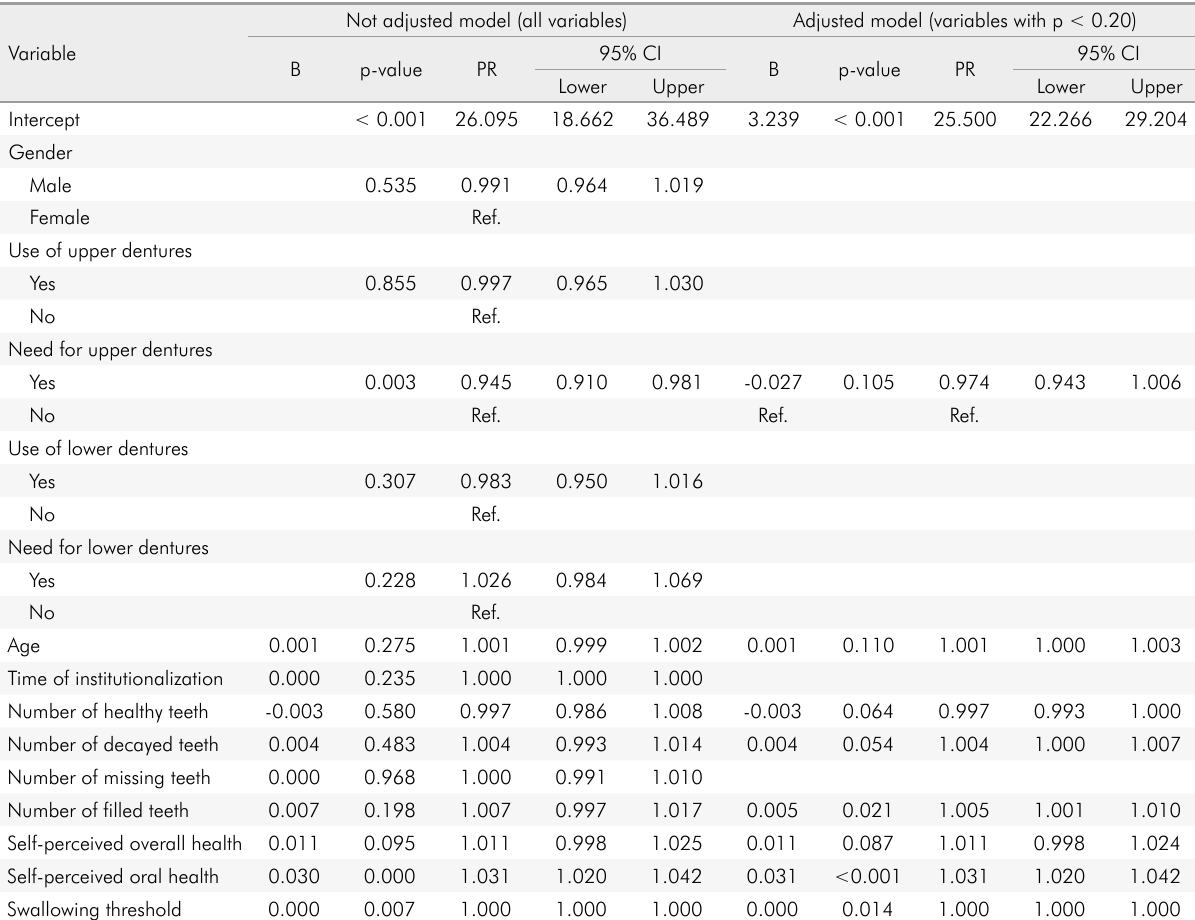
Table 4. Unadjusted and adjusted models of Poisson multivariate regression to investigate the factors associated with OHRQoL (measured by the GOHAI questionnaire) among institutionalized elderly individuals in the cities of João Pessoa and Piracicaba, Brazil (2019). Not adjusted model (all variables) Adjusted model (variables with p < 0.20) Variable